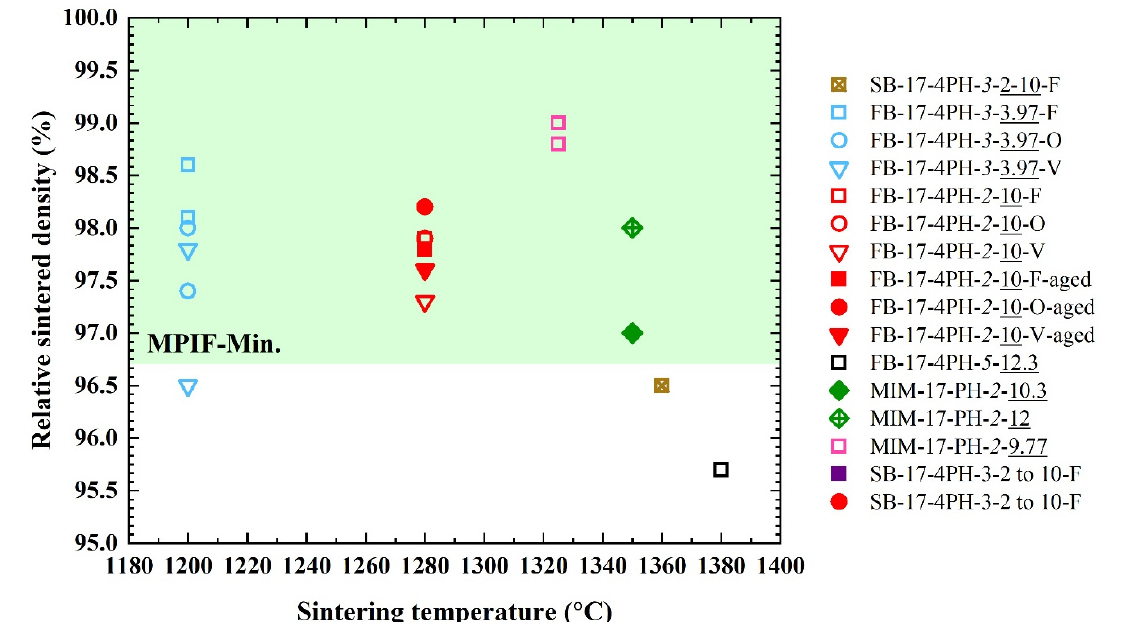
Figure 19. Sintering temperature vs. relative sintered density map of 17-4PH stainless steel fabricated by metal MEX process with different conditions comparing with MPIF standard 35 for MIM materials. The italic number represents sintering time (h) and the underlined number represents powder size (µm). F, O and V represent flat, on-edge and vertical printing orientations, respectively Data from [8,49,64,92,110,134,157,169].